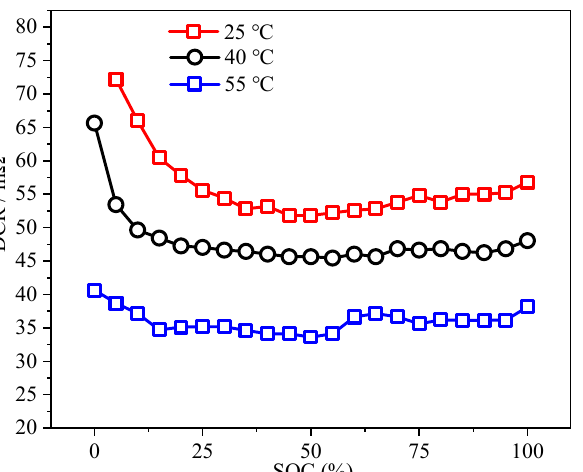
Figure 13. Internal resistance measured by hybrid pulse power characteristic (HPPC), under different ambient temperatures.